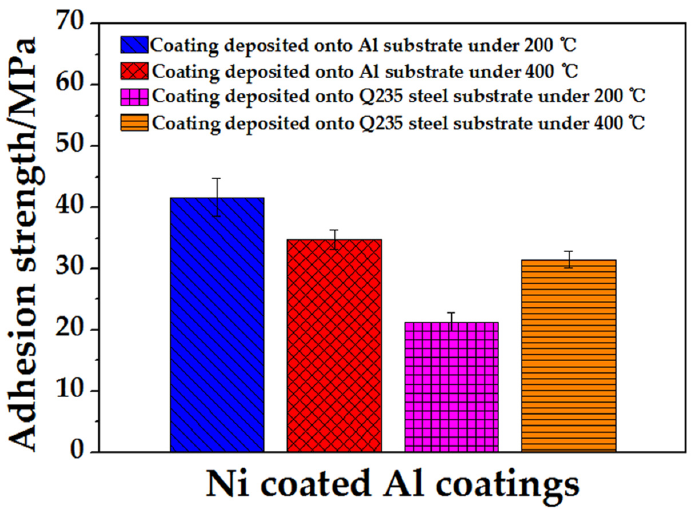
Figure 13. Adhesion strength of Ni-coated Al coatings deposited onto different substrates at different accelerating gas temperatures.